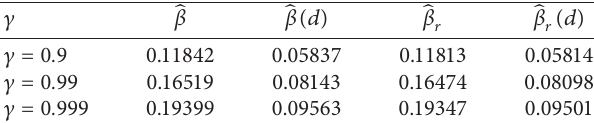
Table 1: The estimated MSE of the estimators when n � 30.